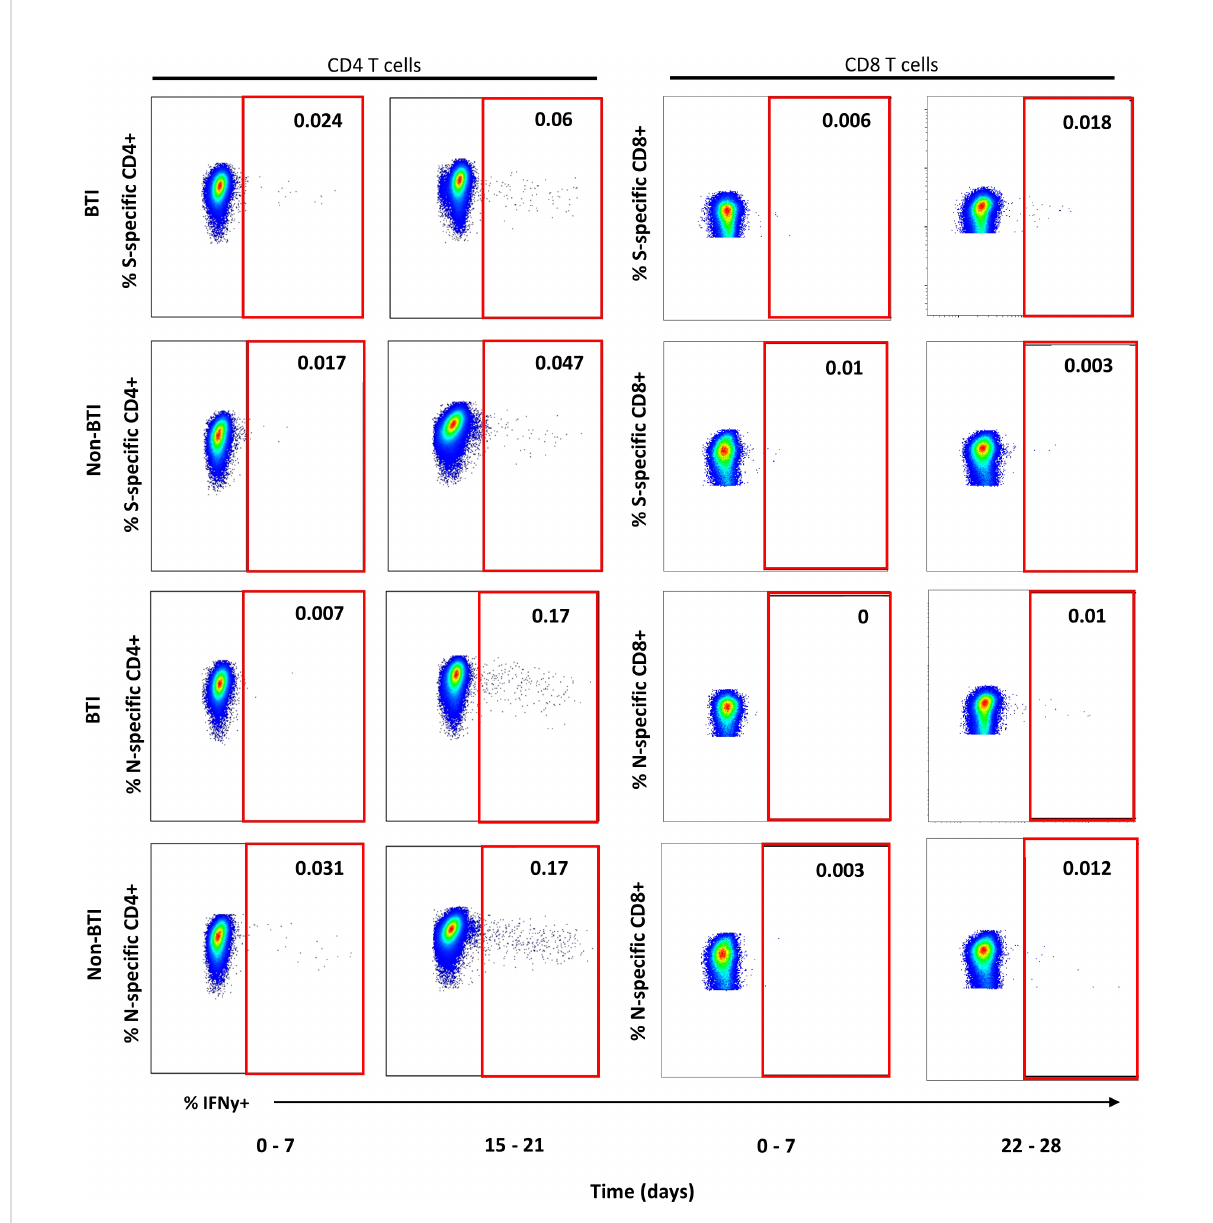
FIGURE 1 Representative dot plots for detection of IFNy+ T cell targeting vaccine-encoded Spike and non-encoded Nucleocapsid protein. Representative dot plots from intracellular cytokine staining experiments gated on CD4+ (left plots) or CD8+ T cells (right plots) are shown for one breakthrough (BTI) and one non-breakthrough (non-BTI) infection case for peripheral blood mononuclear cells restimulated Spike and Nucleocapsid peptide pool as indicated. The red square indicates the gate for de fi ning antigen-speci fi c IFNy+ T cells within the CD4 or CD8 T cell parent population. The frequencies of IFNy+ T cells is indicated as percent of CD4 or CD8 T cells for each shopn gate. Dot plots were produced using FlowJo version